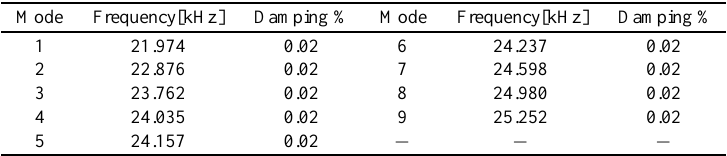
Table 2 The natural frequencies and the damping values for the Micro-flown test